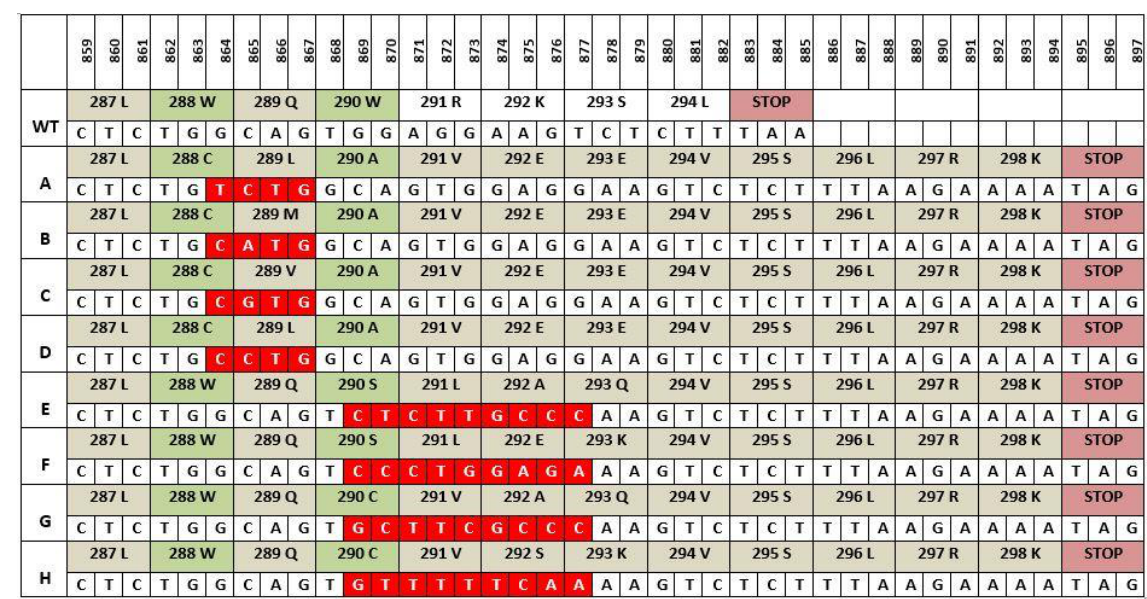
Figure 2. NPM1 exon 12 mutations. Mutation types (A-H) differ in the composition and number of nucleotides inserted (shown in red). All mutants shown have the same 4 amino acid addition at the end and an alteration to at least one of the tryptophans at positions 288 and 290 [42].